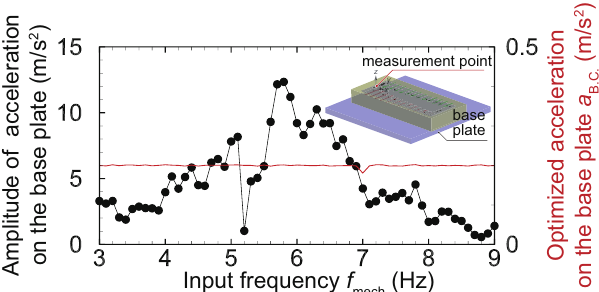
Figure 4. An absolute value of the maximum acceleration at x = y = 0 mm plotted against the input frequency f mech under an applied electrical stimulus of V in ( t ) = V in sin ( 2 π f mech t ) , where V in = 5 V. The maximum acceleration varied with the input frequency, so the electrical stimulus applied to the actuator was optimized to evaluate the frequency characteristic of the device by applying the appropriate oscillation. The optimized amplitude of the acceleration at the boundary is shown by the red solid